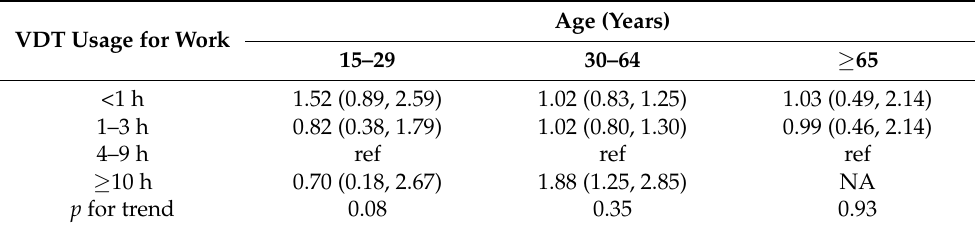
Table 4. Association between the VDT usage for work and self-rated health stratified by age groups.